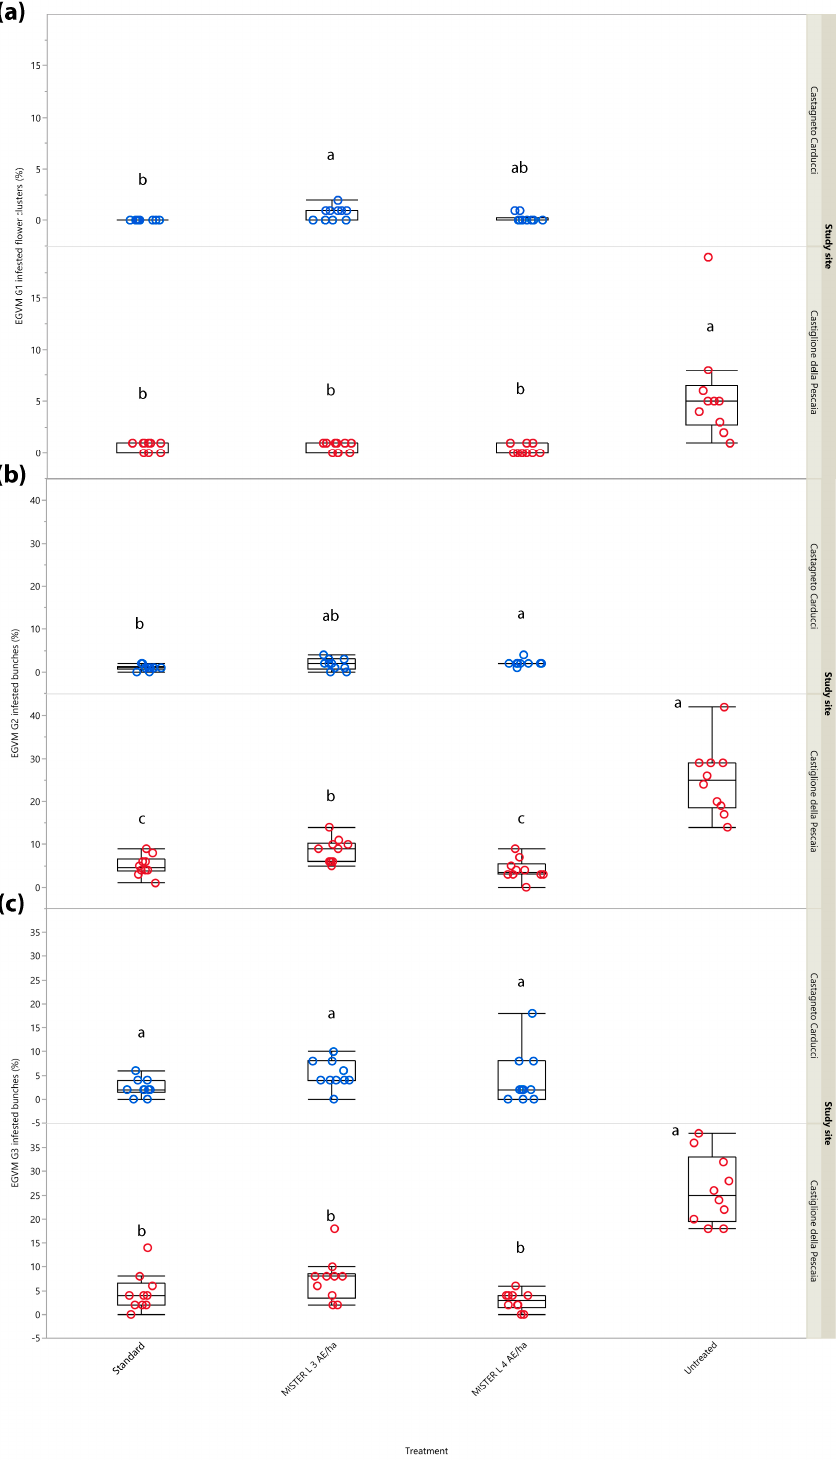
Figure 3. Impact of mating disruption using Isonet ® L MISTERX843 on the percentage of flower clusters (G1) or bunches (G2 and G3) infested by Lobesia botrana (EGVM) in Tuscany during 2018. Box plots indicate the median (solid line) within each box and the range of dispersion (lower and upper quartiles and outliers) of the infestation parameter. ( a ) G1: first generation; ( b ) G2: second generation; ( c ) G3: third generation (harvest). Within each generation and study site, different letters above box plots indicate significant differences between treatments (Kruskal–Wallis test followed by Steel–Dwass test, p <